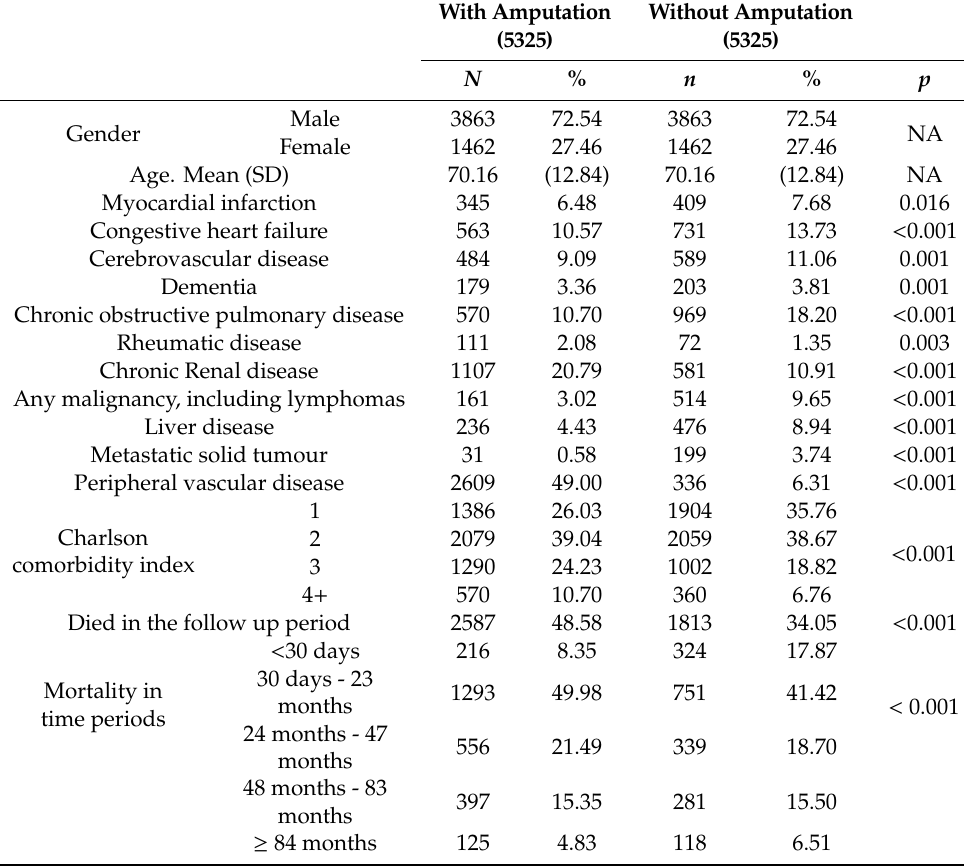
Table 2. Characteristics of T2DM patients who underwent a LEA and matched T2DM patients hospitalized without